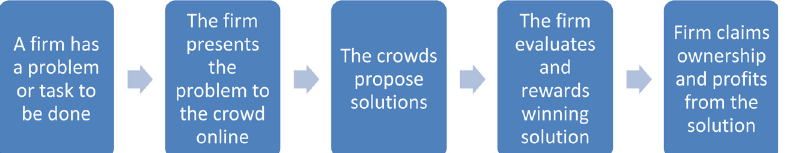
Figure 1. General approach of